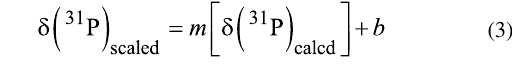
Table 1: MAD a and RMSD a (ppm) for scaled 31 P NMR chemical shifts. b